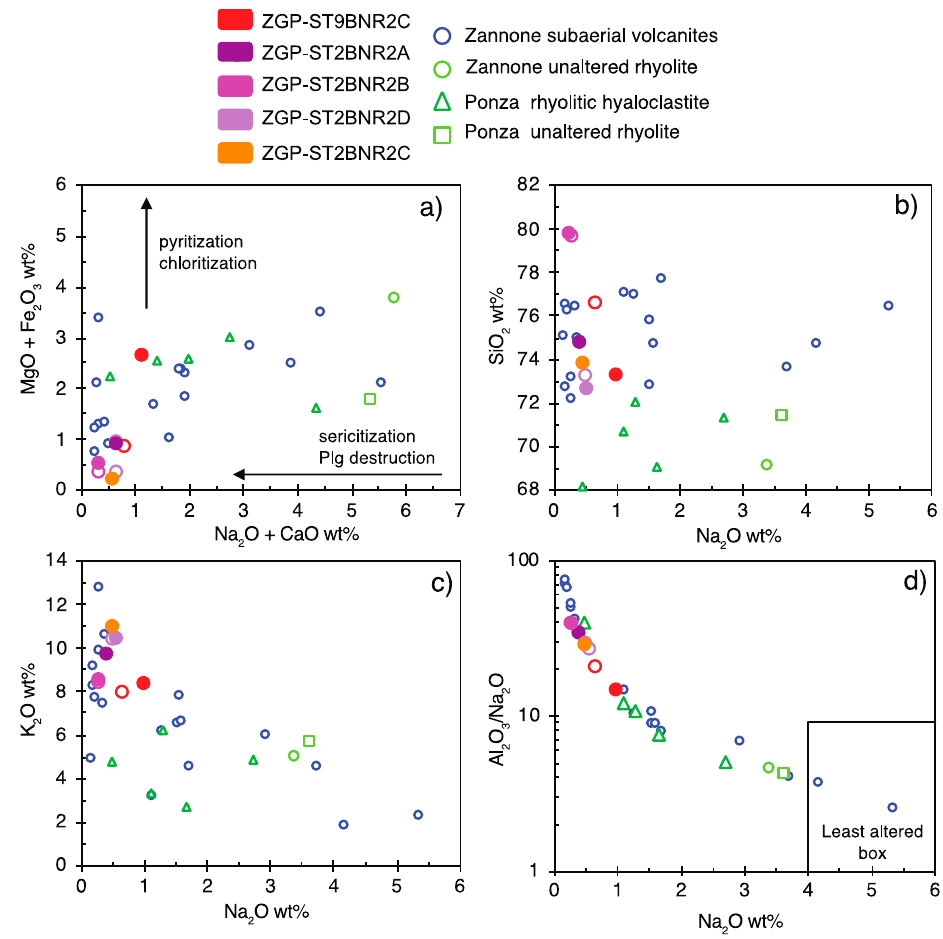
Figure 12. Mobile elements diagrams for ZGP clasts. ( a – c ) ZGP clasts show depletion in Na 2 O, CaO, MgO, and FeO, suggesting that hydrothermal alteration was dominated principally by destruction of primary feldspar, sericitization, and pyritization processes that lead to Na, Ca, Mg, and Fe elements loss and gain of K and Si. ( d ) Spitz-Darling index [29] versus Na 2 O (diagram after [30]). Zannone subaerial volcanites are from Conte and Dolfi [26]; Zannone and Ponza unaltered rhyolites are samples s5 and s13 in Conte et al. [28]). Data representative of unaltered and weak to intense altered rhyolitic hyaloclastite from Ponza (argillitic, propylitic, silicic, and sericitic zones) are from Altaner et al. [27].